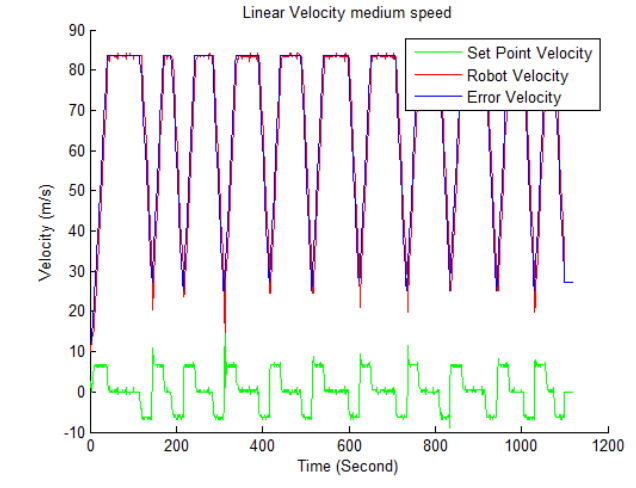
Figure 23. Medium-speed Performance in Linear Velocity.